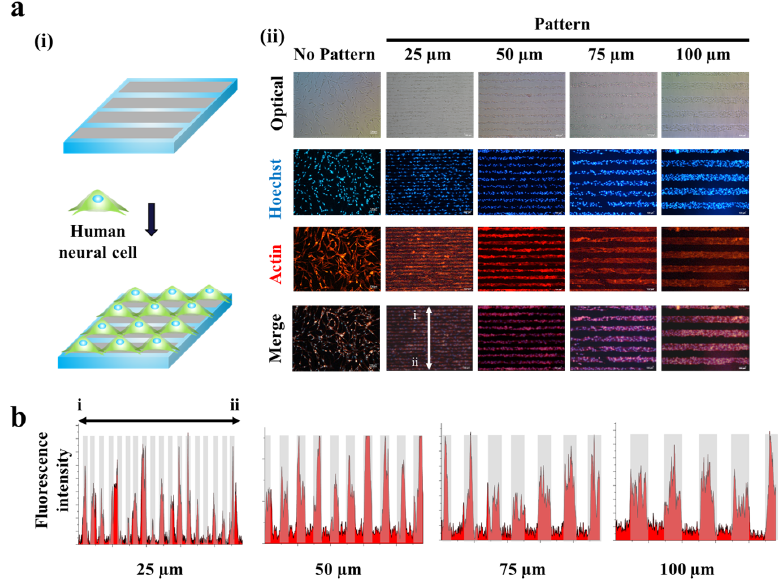
Figure 3. Human neuronal cells (SH ‐ SY5Y) cultured on GO hybrid line patterns. ( a ) Schematic diagram of cells aligned on GO hybrid line patterns ( i ). Phase contrast (top row) and Fluorescence image of SH ‐ SY5Y cells stained for nucleus (blue, second row), actin (red, third row) and merged (last row). Cells cultured on the GO hybrid pattern shows morphology of cells that followed the geometry of the GO hybrid line pattern compared to no pattern. Scale bar = 100 μ m ( ii ). ( b ) Fluorescence intensity profile of phalloidin that shows the size of cell cultured on GO hybrid line patterns. (25, 50, 75, 100 μ m) Red color represents the region where cells are attached, which matches the size of the pattern.